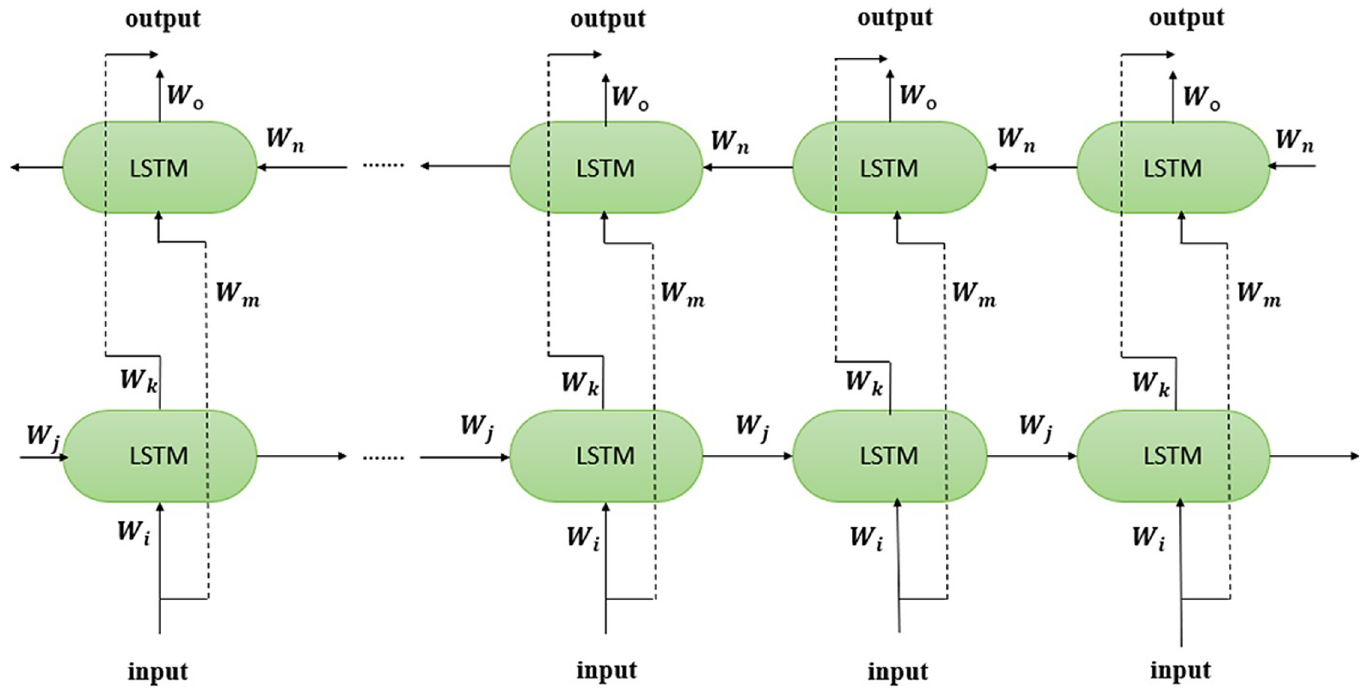
Fig 3. Bidirectional LSTM (Bi-LSTM)